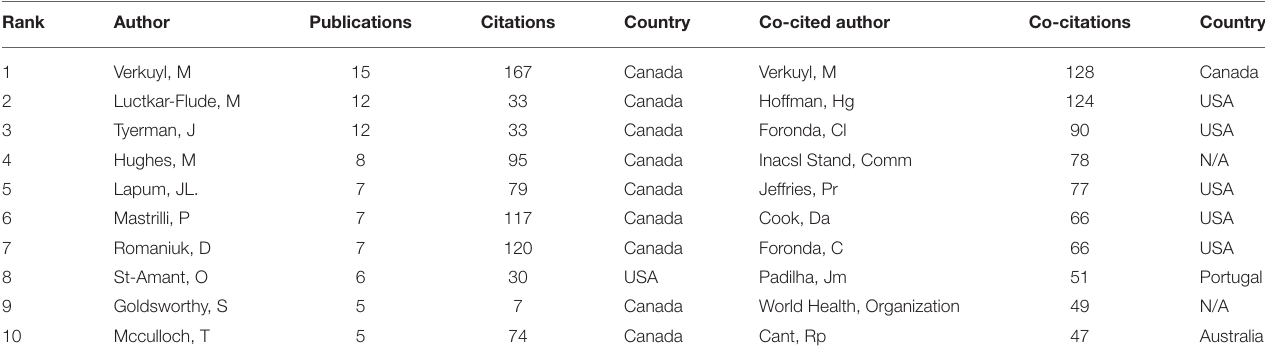
TABLE 1 | Top 10 prolific authors and co-cited authors on virtual simulation research in